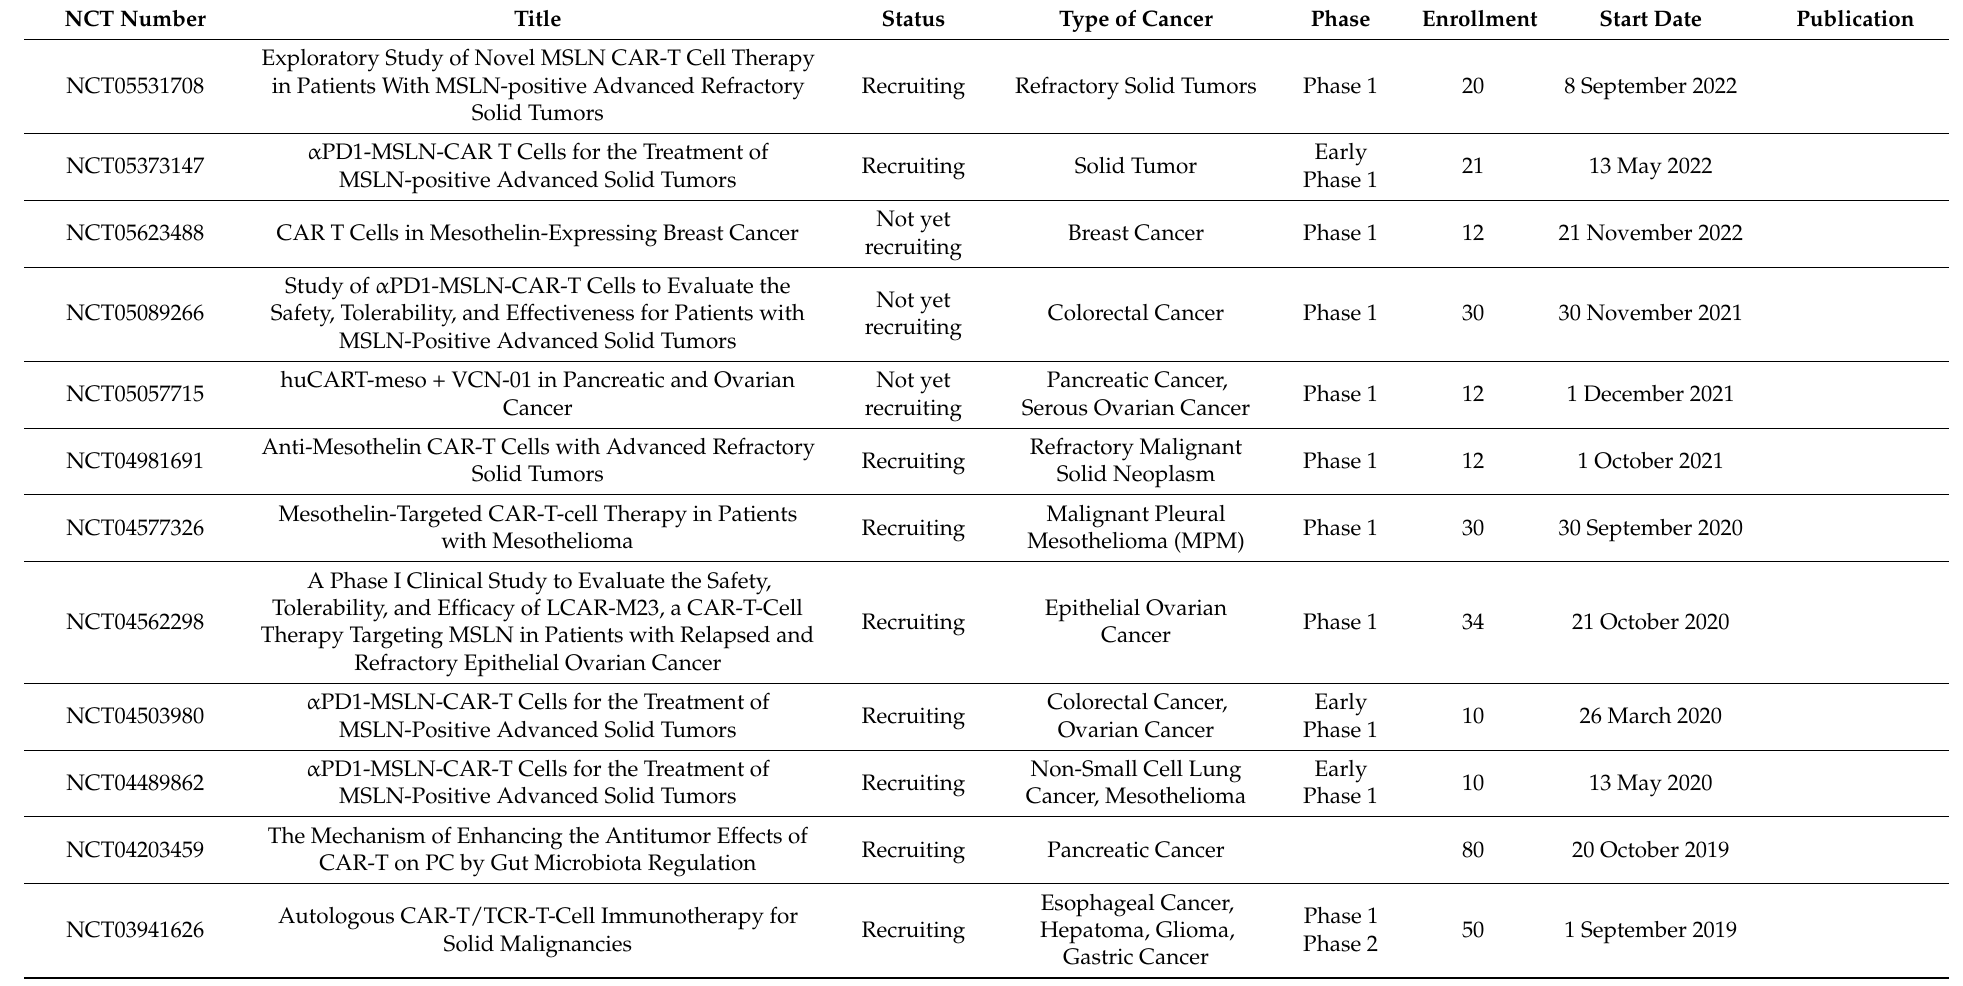
Table 1. Clinical trials using anti-MSLN CAR-T therapy for solid